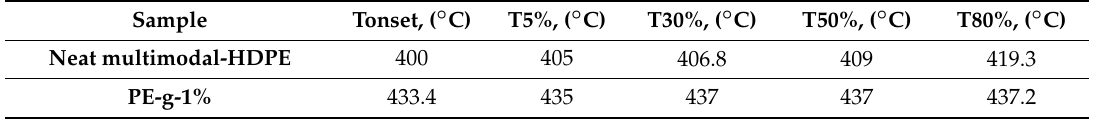
Table 1. TGA data of the neat multimodal-HDPE and its